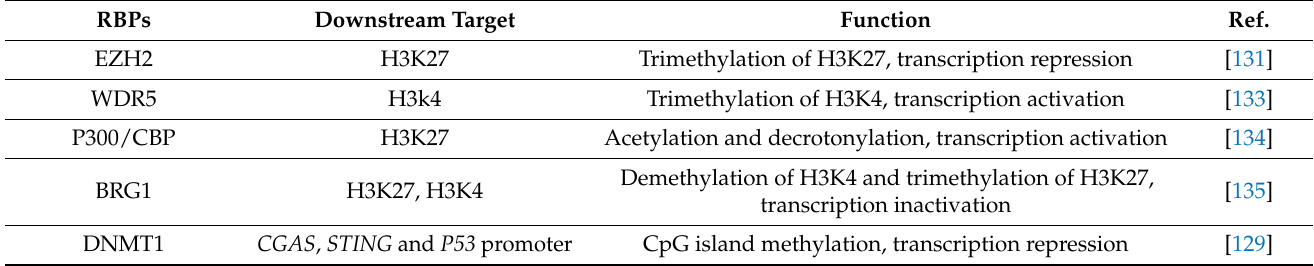
Table 2. RNA-binding Proteins bound with NEAT1-regulating gene expression.